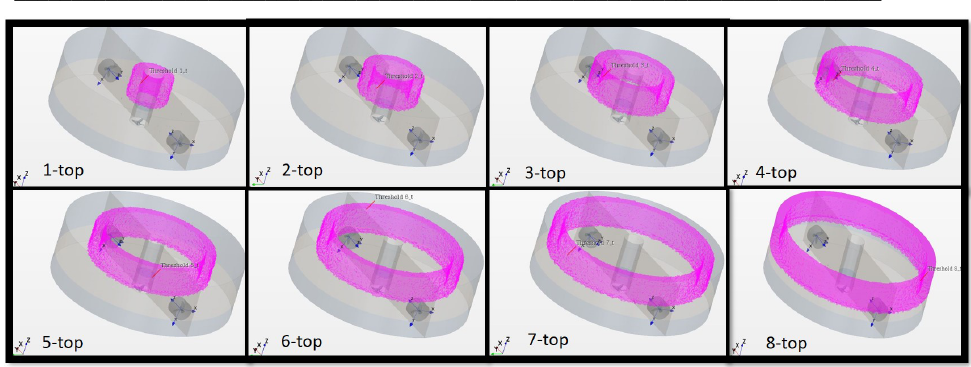
Fig. 2. Examples of partition of the tank volume (grey) in circular subregions (purple): a) 1_b; b) 3_b; c) 5_b; d) 7_b top subregions